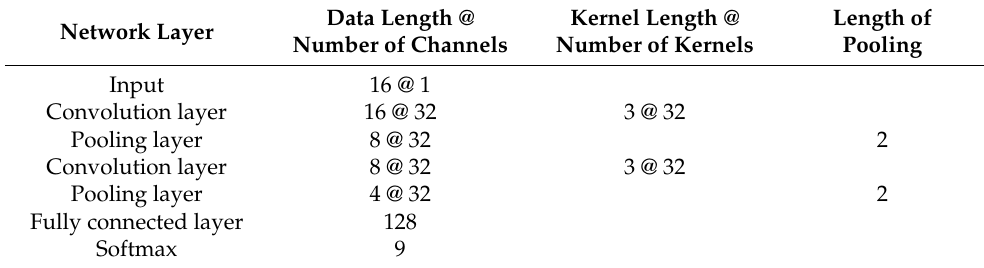
Table 1. WPE-CNN structure parameter